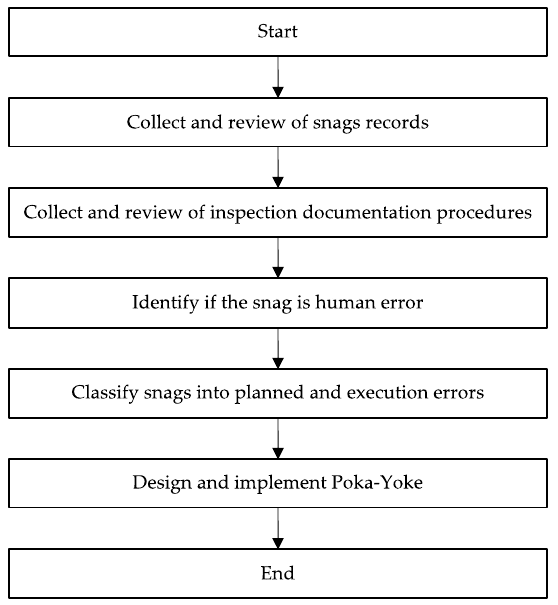
Figure 2. Workflow of the implementation of the proposed framework.